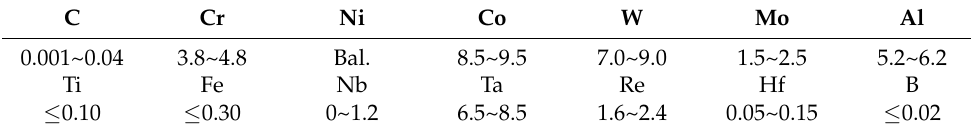
Table 1. Nominal chemical composition of the nickel-based superalloy in wt.%.